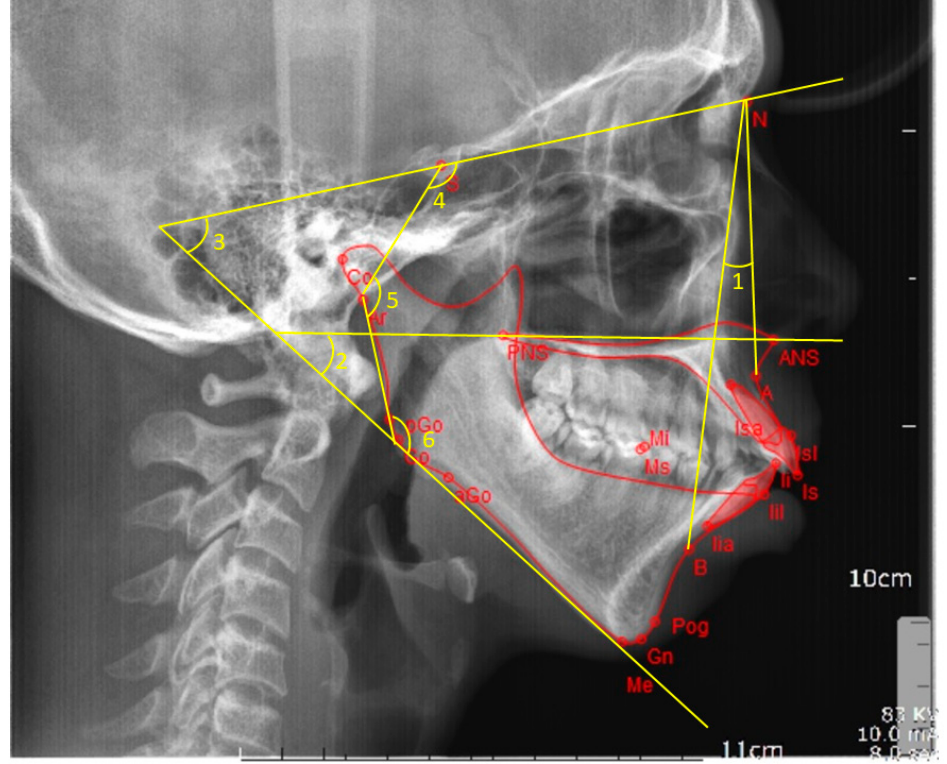
Figure 1. Angular cephalometric measurements. 1 = ANB angle, 2 = intermaxillary angle, 3 = mandibular plane angle, 4 = saddle angle, 5 = articular angle, and 6 = gonial angle.